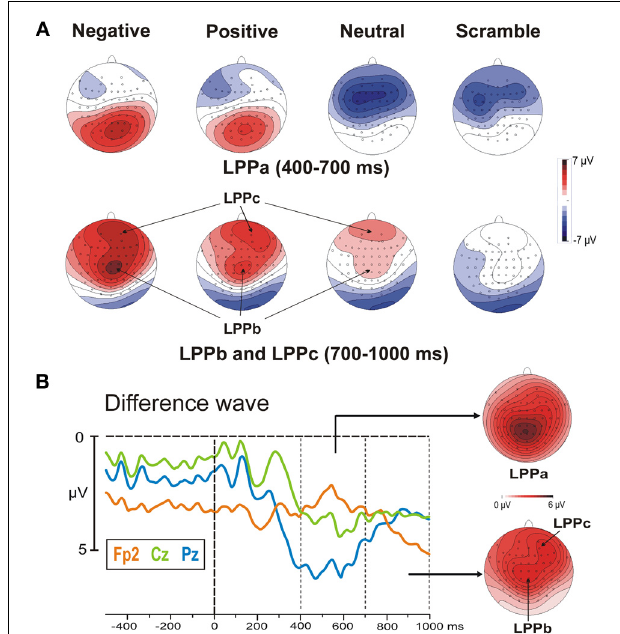
FIGURE 3 | (A) Post-stimulus scalp topographical distribution of the LPPa, LPPb, and LPPc in the four experimental categories. It can be observed that negative and positive stimuli elicit larger LPPs. Specifically, the LPPa, LPPb, and LPPc show the maximum activity over posterior, frontal and prefrontal areas, respectively. (B) High arousing (positive and negative) minus low arousing (neutral and scramble) categories: differential waves in three representative sites and topographical distribution of the